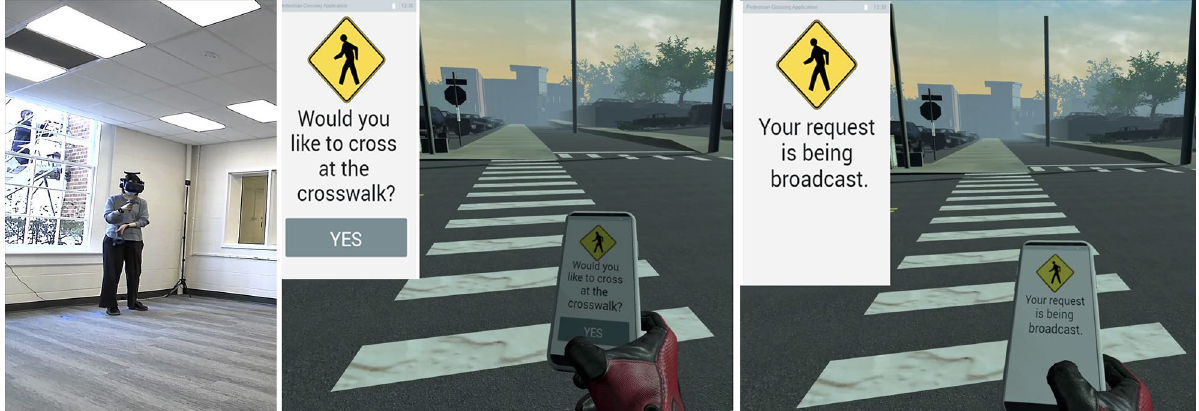
Figure 6. A pedestrian is using smartphone app (left), pedestrian’s point of view in IVE (middle), smartphone app user interface before and after pressing (right), a sample video is available in the following link https:// youtu. be/Q_ LUoIZ